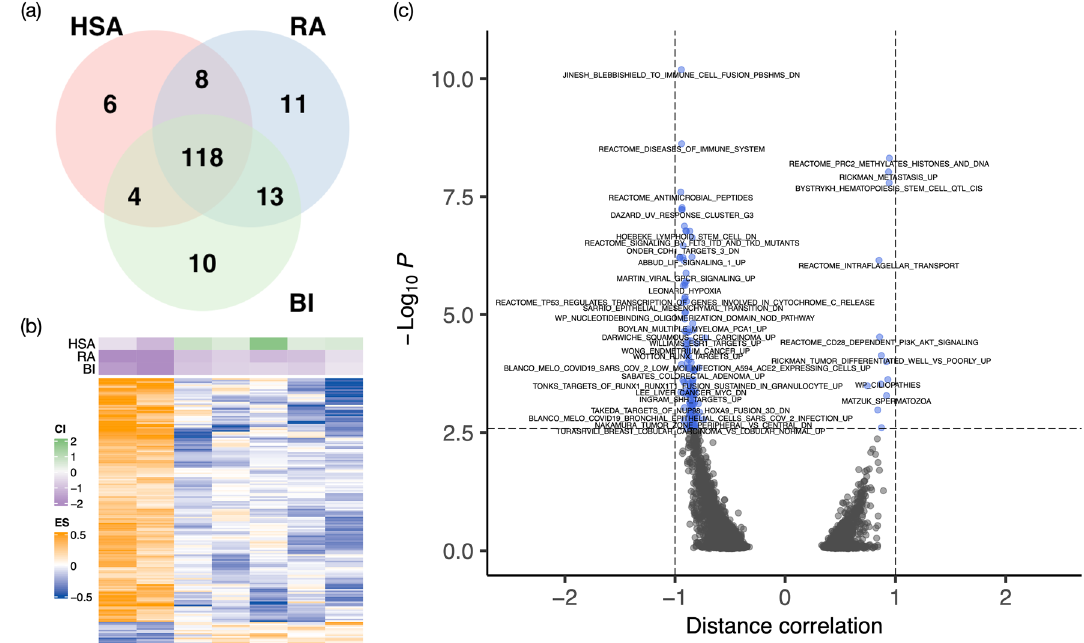
Figure 3. Differentially activated pathways at FDR of 0.1 for KRT232 plus navitoclax. ( a ) Venn diagram showing distribution of significantly expressed pathways. The figure illustrates the number of statistically significantly expressed pathways associated with each gCI ( b ) Heatmap of baseline pathway enrichment score from GSVA with the row annotation to be gCI . Each column represents a PDX model, and each row represents a gene whose enrichment score was significantly correlated with one or more gCI using the distance correlation test. ( c ) Volcano plot showing that p-value versus distance correlation for BI (the direction of the correlation is obtained by Spearman correlation). Blue dots represent significant differential pathways and black dots represent insignificant pathways. Panel ( a ) was generated using the R package VennDiagram 40 (version 1.6.0 https:// cran.r- proje ct. org/ web/ packa ges/ VennD iagram/ index. html), Panel ( b ) was generated using the R package ComplexHeatmap 41 (version 2.6.2 https:// github. com/ joker goo/ Compl exHea tmap), and Panels ( c ) was generated using the R package EnhancedVolcano 42 (version 1.8.0 https:// github. com/ kevin blighe/ Enhan cedVo